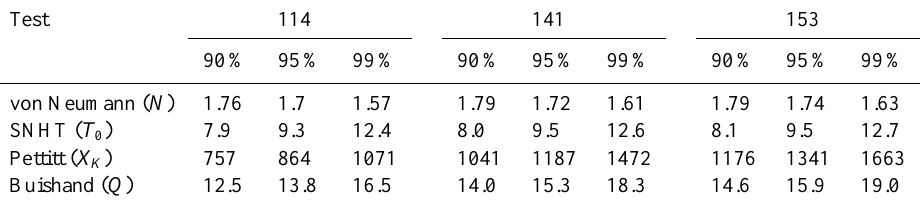
Table 1. The 90%, 95% and 99% critical values for the following homogeneity test statistics: N of the von Neumann ratio test, T 0 of the SNHT, X K of the Pettitt test and Q of the Buishand partial sum tests, for data sets with di ff erent lengths (114, 141 and 153 elements). Test 114